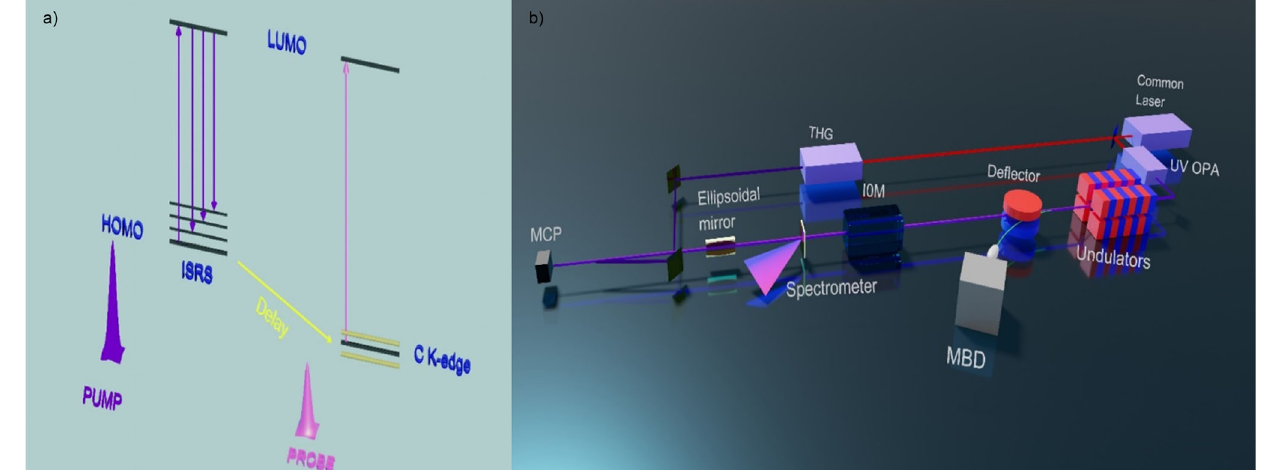
Fig. 4 | Sketch of the ISRS process and of the FEL layout. a Pulse scheme of the experiment with the relevant energy levels: The 4.7eV pump pulse (purple pulse) generates acoherentsuperpositionof vibrationallevels in theHOMO by impulsive stimulated Raman scattering (ISRS). These modes are then probed with element- selectivity by the soft X-ray pulse (light purple pulse) tuned to the carbon K-edge. b Theexperimentallayout.A786nmfemtosecondlaserpulseissplitanddelivered to an optical parametric ampli fi er (OPA) where it is up converted to generate the